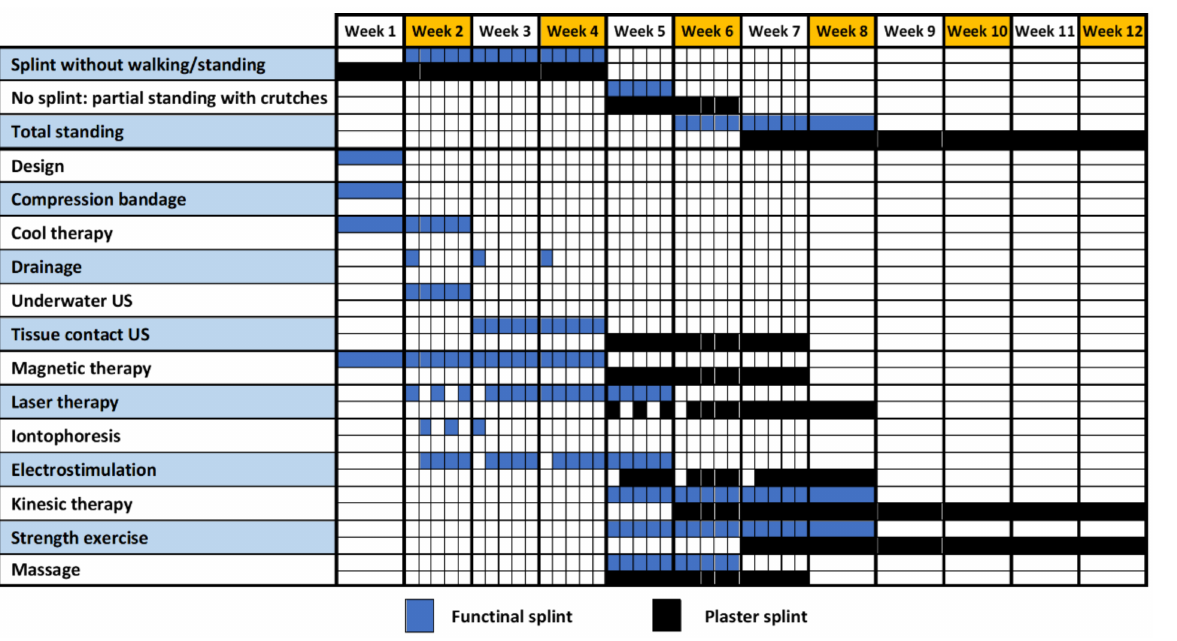
Figure 2. Chronogram of rehabilitation with new techniques applied [10].